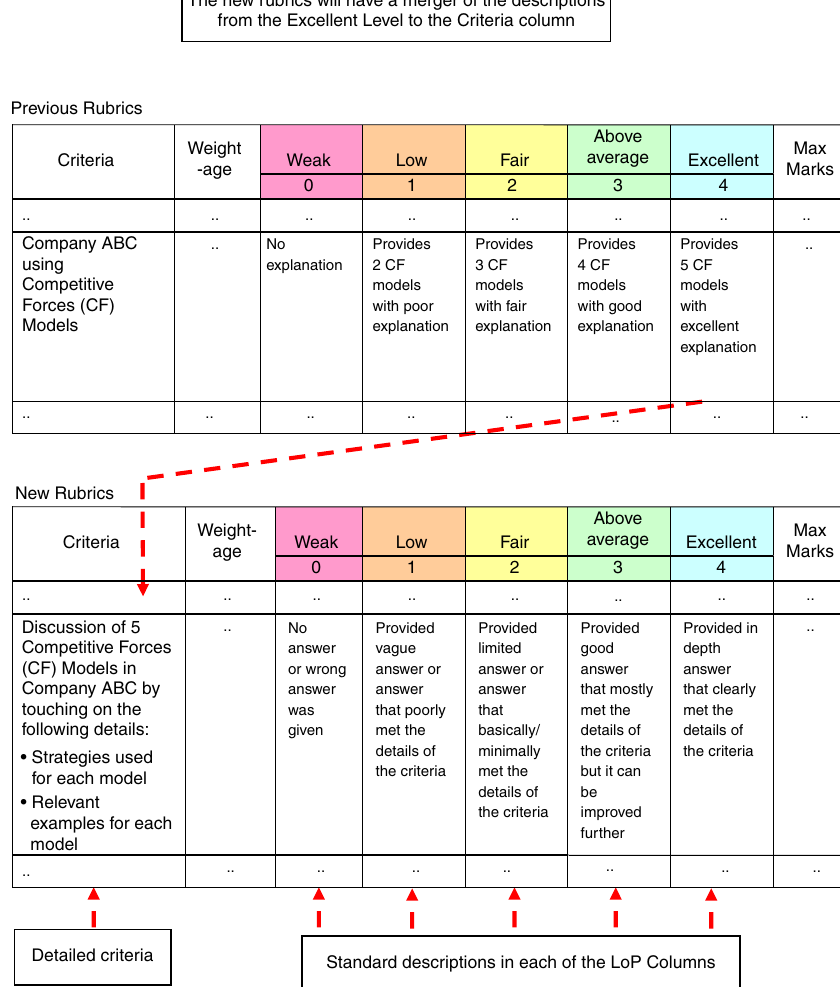
Figure 7. Example of new criteria with detailed